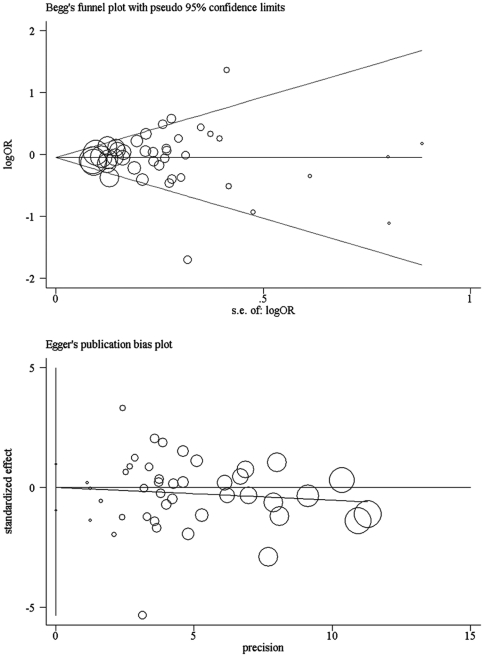
Funnel plots of Begg's and Egger's were used to detect publication bias on overall estimate.No significant publication bias was found. Each point represents an individual study for the indicated association.